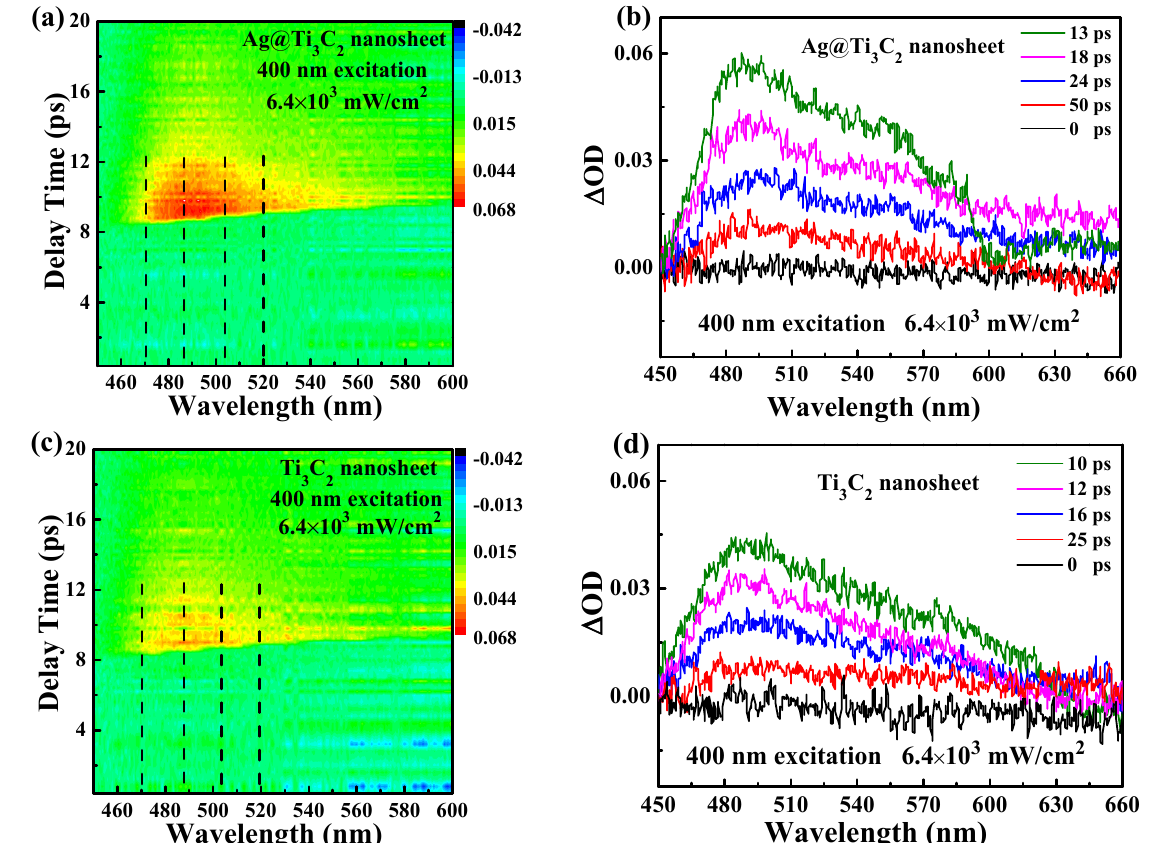
Figure 5. ( a , c ) Two-dimensional (2D) mapping of transient absorption (TA) spectra for Ag@Ti 3 C 2 and Ti 3 C 2 nanosheet pumped at 400 nm with a fluence of 6.4 × 10 3 mW/cm 2 . ( b , d ) Time and wavelength resolved transient absorption data of Ag@Ti 3 C 2 and Ti 3 C 2 nanosheet.